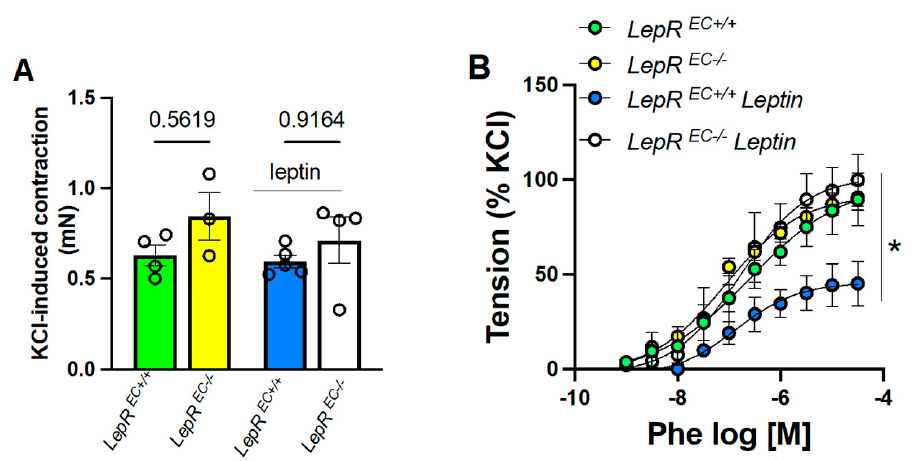
Figure 5. Leptin-mediated reduction in adrenergic vascular contractility requires intact endothelial- leptin signaling. KCl-induced vascular contractility ( A ), and concentration response curves (CRC) to phenylephrine ( B ) in aortic rings from wild type (LepR EC +/+ ) and endothelial leptin receptor deficient mice (LepR EC-/- ) treated or not with leptin (0.3 mg/Kg/day for 1 week, via osmotic mini-pump) ( B ). Data are presented as mean ± S.E.M. N = 4. * p < 0.05 WT vs. LepR EC-/- mice.